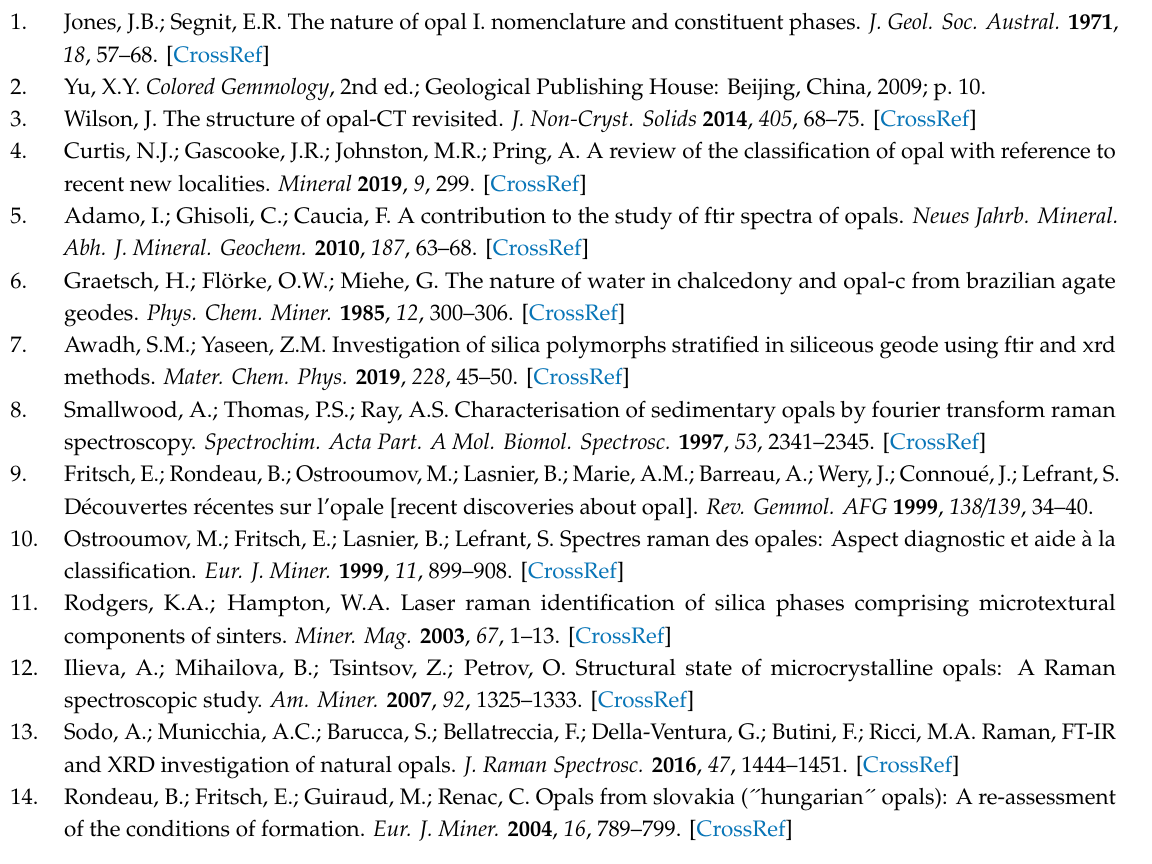
Figure S1: Error Bars of the η and ξ values of di ff erent areas in Opal-02 and 04, Equation (S1): The formula for estimating the standard error of η , Equation (S2): The formula for estimating the standard error of ξ